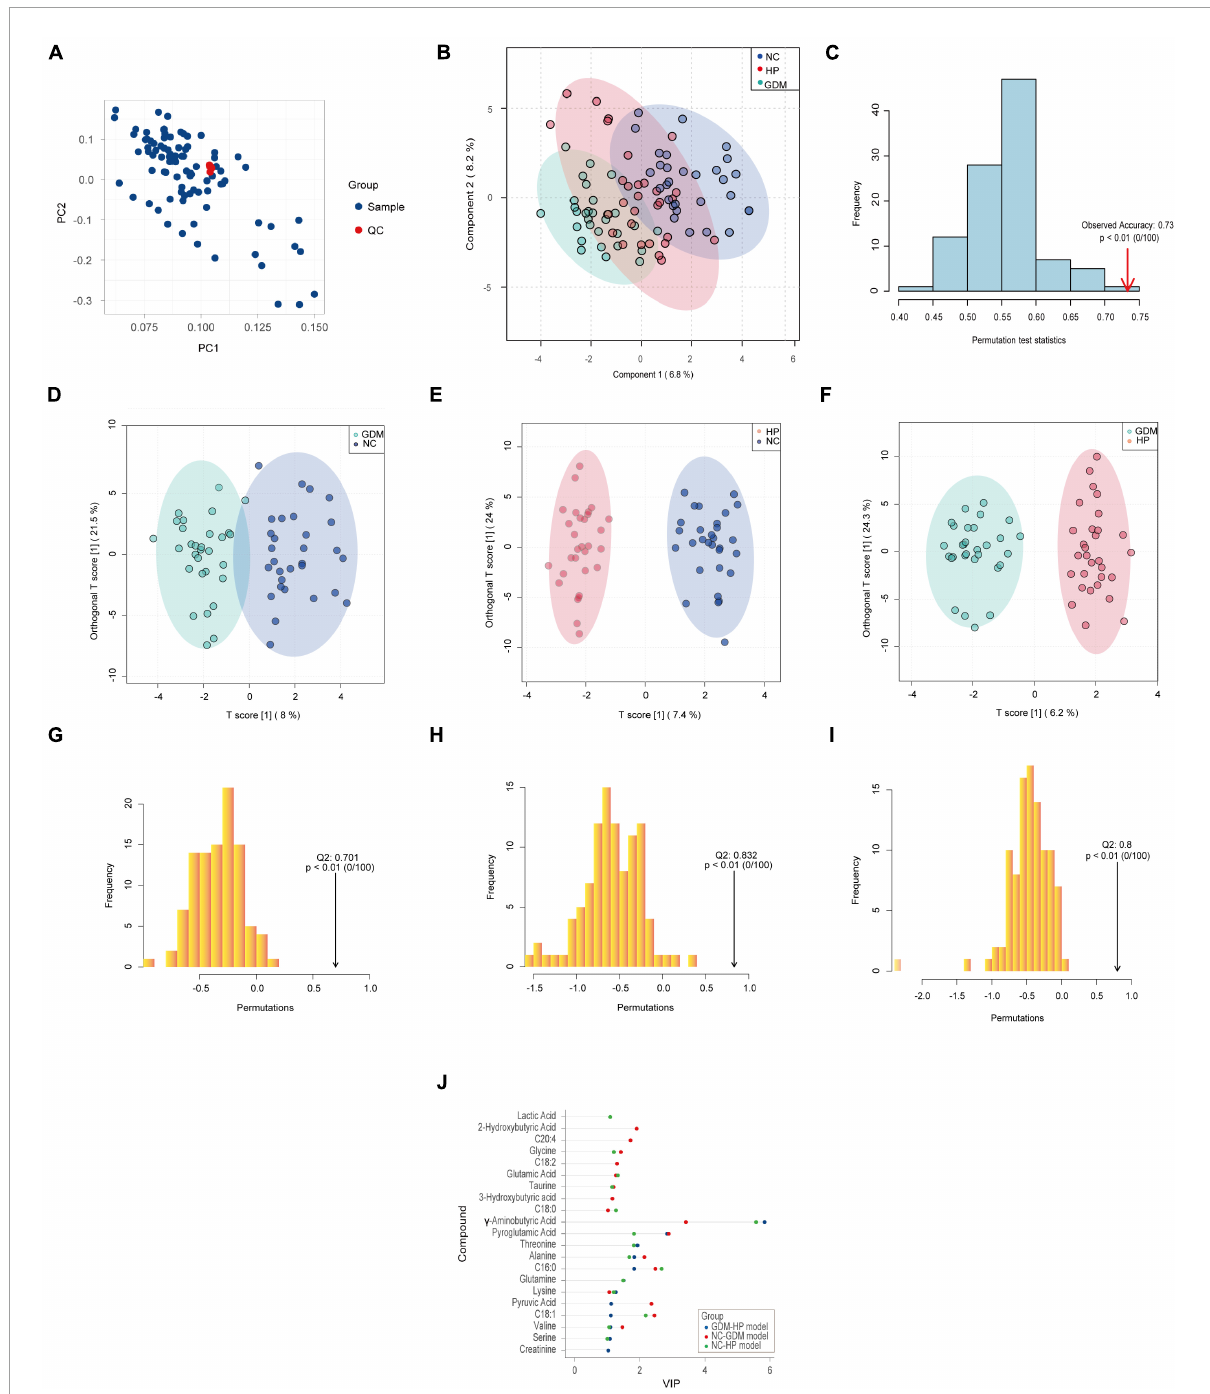
FIGURE2 Typical metabolic profiles revealed by PLS-DA and OPLS-DA. (A) PCA analysis of 90 samples with QC. (B) PLS-DA analysis among three groups, with R2Y (cum) = 0.802 and Q 2 (cum) = 0.725. (C) Permutation tests of PLS-DA discrimination models among three groups. (D) The score plots of the OPLS-DA model between NC and GDM, with R2Y (cum) = 0.812 and Q 2 (cum) = 0.701. (E) The score plots of the OPLS-DA model between NC and HP, with R2Y (cum) = 0.948 and Q 2 (cum) = 0.832. (F) The score plots of the OPLS-DA model between GDM and HP, with R2Y (cum) = 0.923 and Q 2 (cum) = 0.800. Permutation tests of OPLS-DA discrimination models between NC and GDM (G) between NC and HP (H) between GDM and HP and (I) with the Q 2 on the right side of the random distribution and p < 0.01, which indicated the above three OPLS-DA models were reliable and there was no over-fitting phenomenon. (J) VIP values of three OPLS-DA